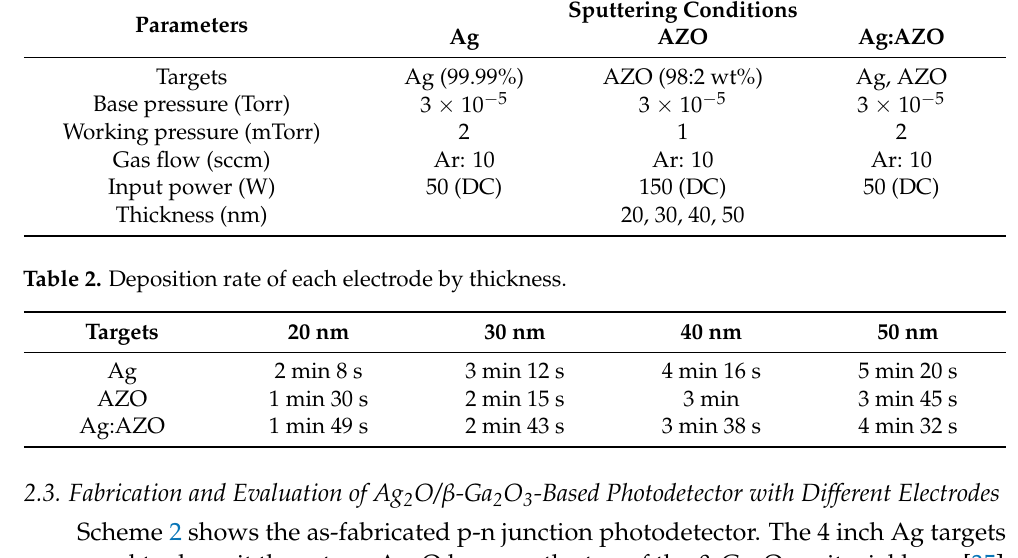
Table 1. Sputtering conditions of each electrode.